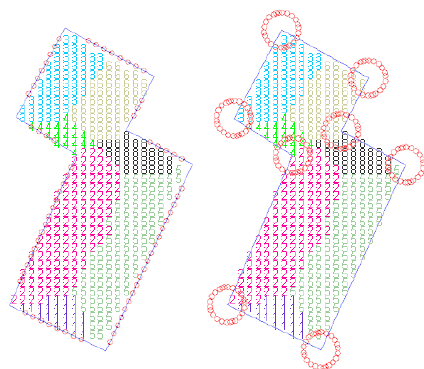
Figure 1. Topology analysis between roof regions/fac¸ades (left) and at fac¸ade corners